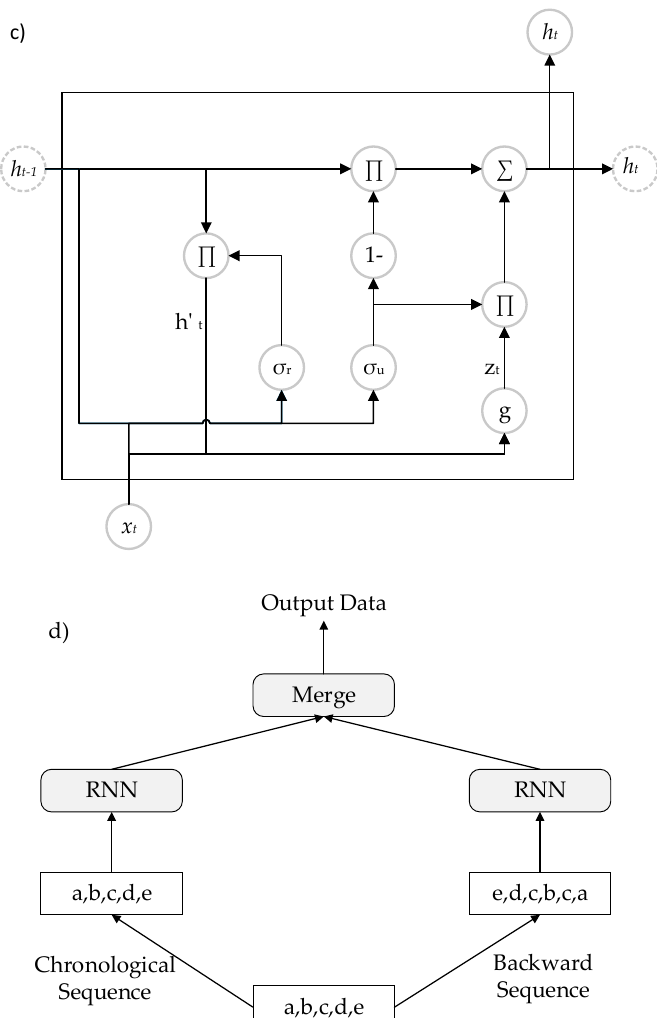
Figure 1. ( a ) Basic RNN unit with the recursive state, ( b ) basic unfolded unit showing relations between different states, ( c ) basic architecture of GRU cell, and ( d ) demonstration of the forward and backward processes of a bidirectional RNN model.